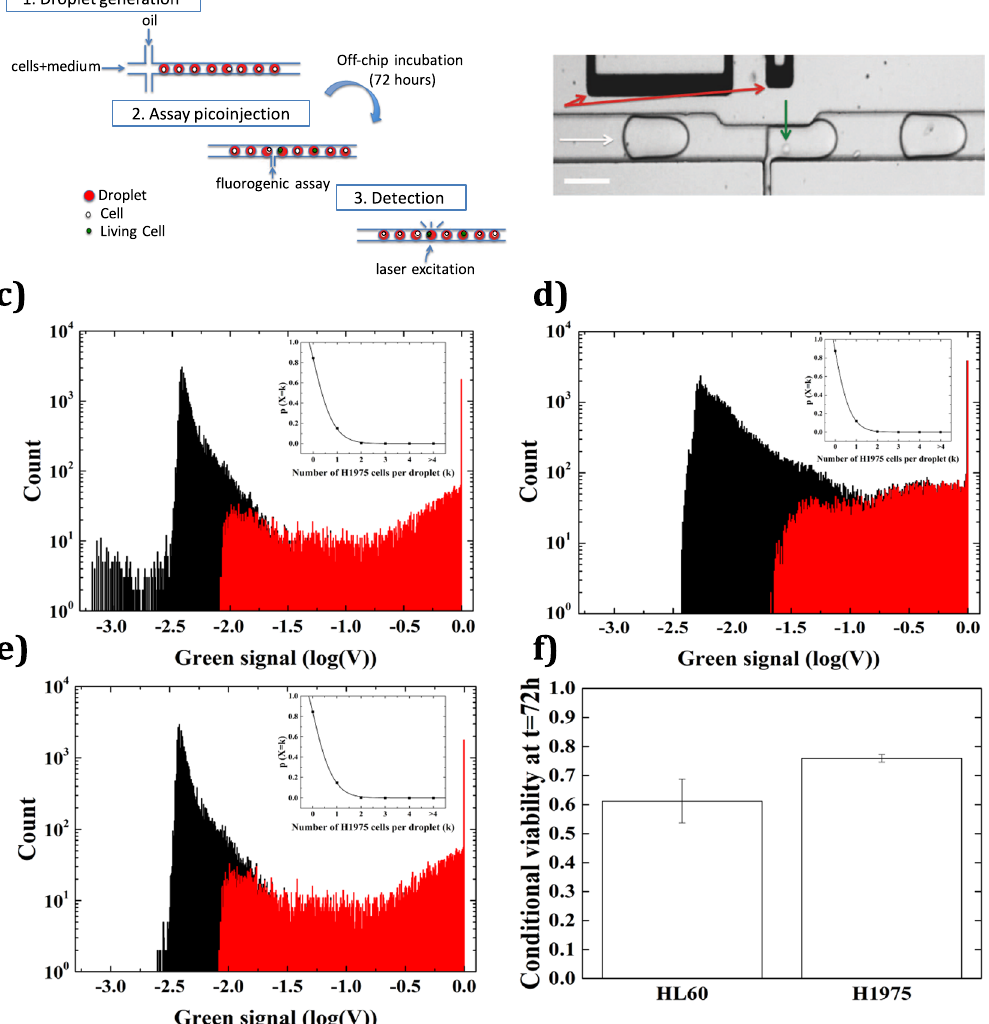
Figure 4. Cell viability. ( a ) Schematic representation of the microfluidic workflow used for the characterization of H1975 and HL60 cells viability in droplets. Cells were encapsulated in droplets with medium and incubated for 72 hours. A fluorogenic assay (Calcein-AM) was then injected in each droplet allowing the fluorescent detection of the droplets containing living cells. ( b ) Image of the electro-microfluidic injection system. The white arrow indicates the droplet flow direction. The green arrow indicates the presence of a cell. When the droplet passes by the injection arm, it is locally destabilized by applying an electric field. The field ruptures the film separating the droplet and reagent, allowing the reagent to be injected. Scale bar: 100 µ m. ( c – e ) Green fluorescence histograms depicting negative (black) and positive (red) cell count events. ( c ) Signal recorded at cell encapsulation with the fluorogenic assay added in bulk. 9,150 cells were counted out of 56,567 droplets resulting in λ = 0.16. Inset shows cell distribution with Poisson fit as a straight line: λ fit = 0.17 ± 0.004 with R 2 = 0.99. ( d ) Signal recorded 72 hours after cell encapsulation. 13,865 cells were counted out of 105,781 droplets resulting in λ = 0.13. Inset: λ fit = 0.14 ± 0.002 with R 2 = 0.99. ( e ) Signal recorded at encapsulation with the fluorogenic assay added drop-by-drop using the electro-microfluidic device. 8,127 cells were counted out of 51,054 droplets resulting in λ = 0.16. Inset: λ fit = 0.17 ± 0.004 with R 2 = 0.99. ( f ) HL60 and H1975 conditional viability following 72 hours of incubation in droplets. HL60: λ t = 72h / λ t = 0h = 0.61 ± 0.07 (mean ± s.d, n = 2). H1975: